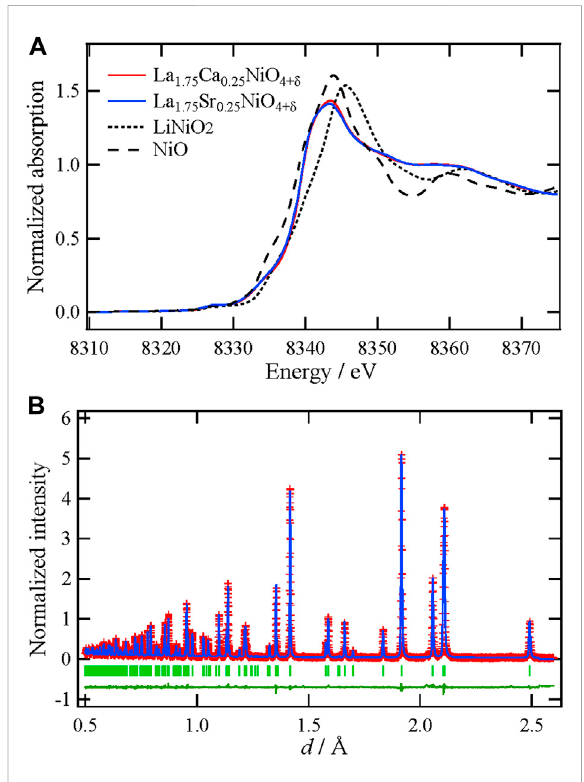
FIGURE 1 (A) XANES spectra at the Ni K -edge of La 1.75 Ca 0.25 O 4+ δ with reference materials (B) The Rietveld re fi nement pattern of La 1.75 Ca 0.25 O 4+ δ using a neutron Bragg pro fi le. Red plus marks show the observed intensities, and the blue solid line represents the calculated intensities. The vertical bars indicate the positions of allowed Bragg re fl ections. The green curve at the bottom is the difference between the observed and calculated intensities at the same scale.